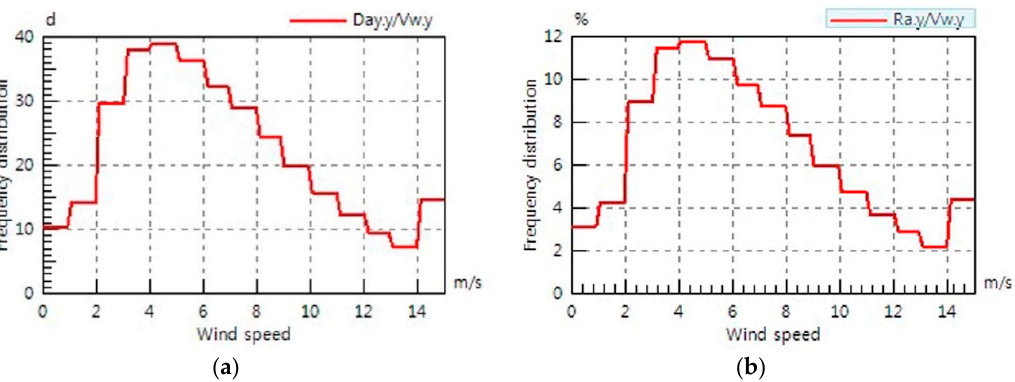
Figure 10. Annual wind speed occurrence frequency in Muan, Jeollanam-do. ( a ) Occurrence days vs. wind speed and ( b ) occurrence rate vs. wind speed.